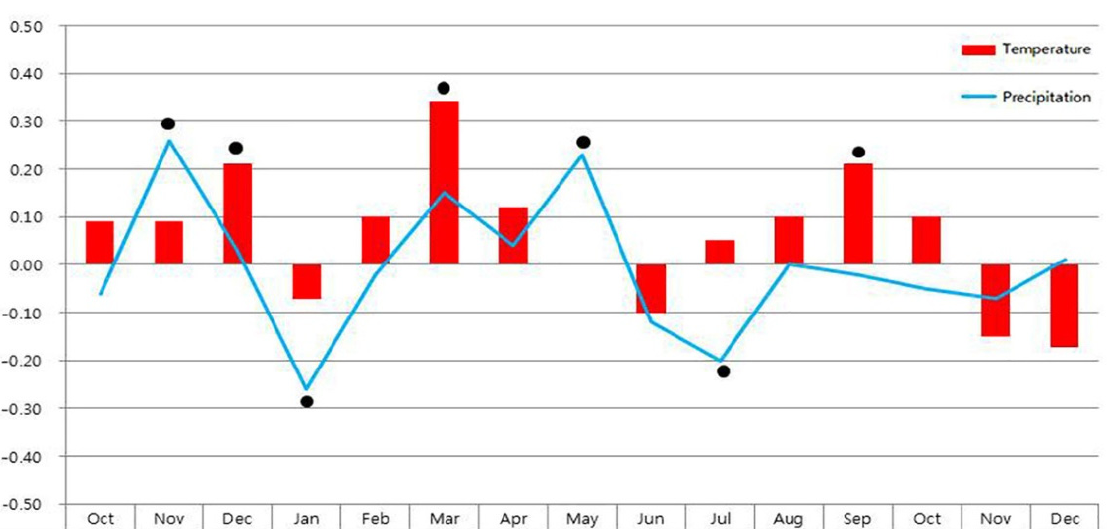
Figure 5. The correlation between climate data and tree-ring chronology of P. densiflora from Mt. Bukhan (significant correlations ( p < 0.05) are indicated with black dots).